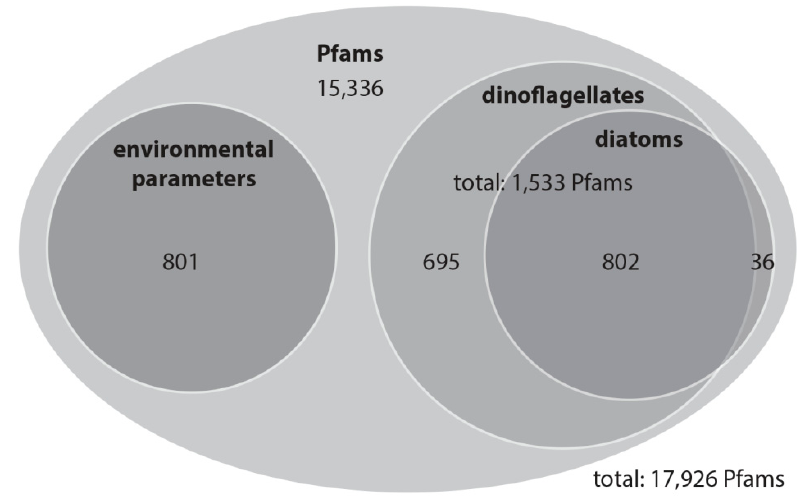
Figure 3. Overview of the Pfam domain distribution as a Venn diagram: numbers represent Pfam domains for which variability is most likely related to changes in environmental parameters (chlorophyll- a , phosphate, salinity, silicate or temperature), relative dinoflagellate abundance, relative diatom abundance or both relative dinoflagellate and diatom abundance.